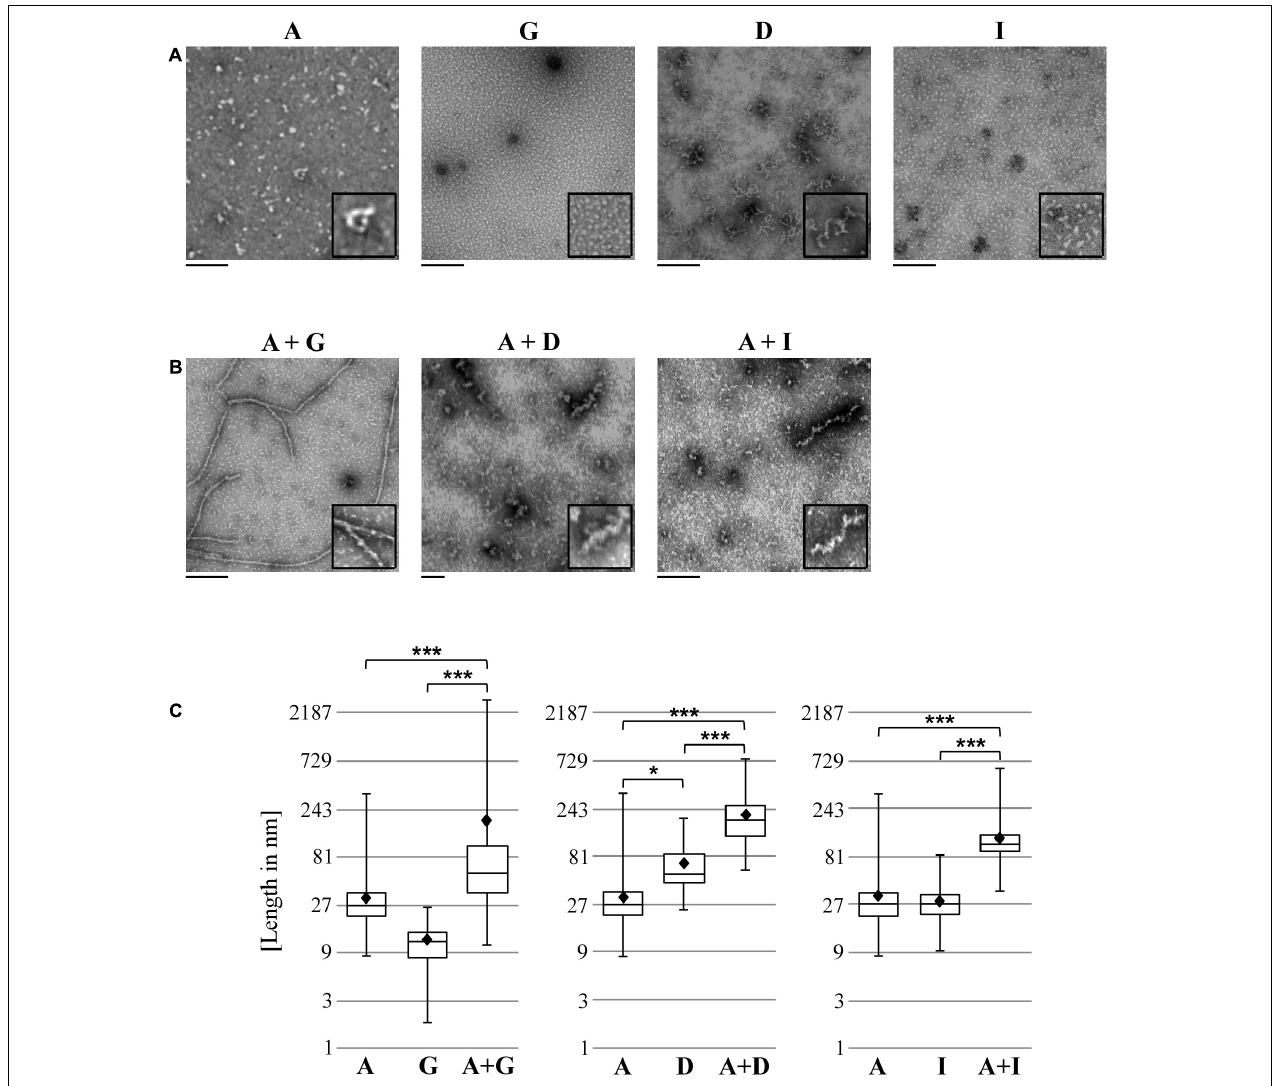
FIGURE 4 | Heteromeric Pmp complexes form longer filaments than homomeric Pmp complexes. Transmission electron microscopy (TEM) pictures of 10 µ l of 0.5 µ M homomeric (A) and heteromeric (B) Pmp oligomers, representative of two (A, G, D, I, and A + G) and three (A + D and A + I) separate experiments. Two-fold enlargements are shown at the bottom right of each image. Scale bar: 250 nm. (C) Lengths of a total of 300 oligomers for each Pmp complex were measured with ImageJ and are displayed in boxplots on a logarithmic scale (base 3). Each heteromeric oligomer is compared to the respective homomeric oligomers. P -values were calculated on the means (shown as black diamonds) using One-way ANOVA followed by Bonferroni’s multiple comparisons test. * p < 0.05, *** p <